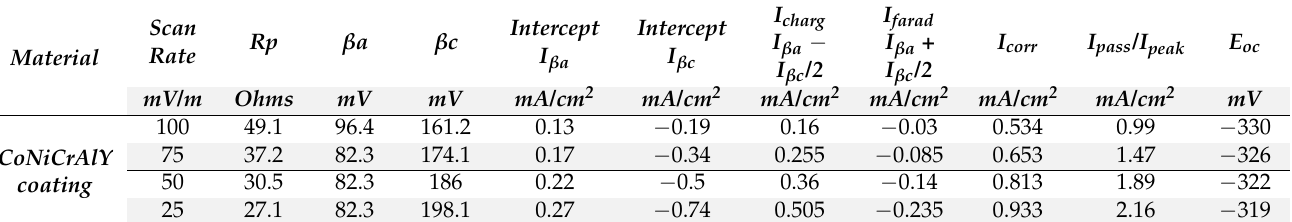
Table 6. Polarization results extracted in active regions at different scan rates.